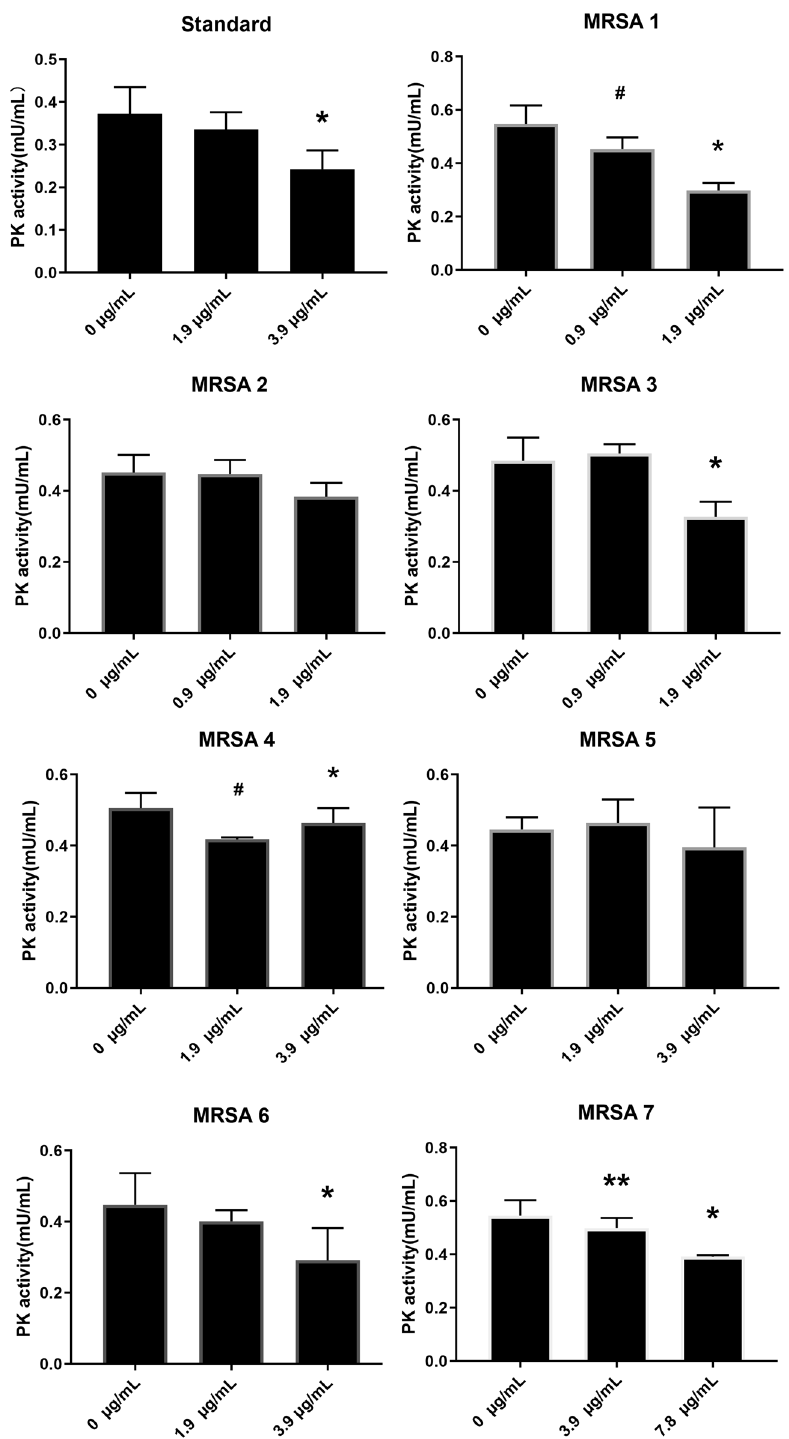
Figure 4. Effect of CT on the activity of PK of eight MRSA strains. # Control group versus 1 × MIC group p < 0.05, *control group versus 2 × MIC group p < 0.05, **:1 × MIC group versus 2 × MIC groups p <